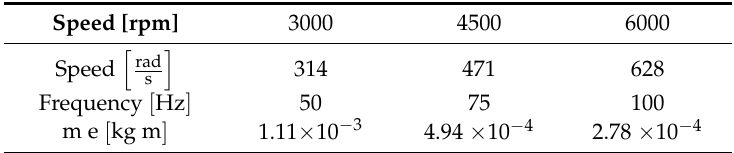
Table 7. Static analysis results.